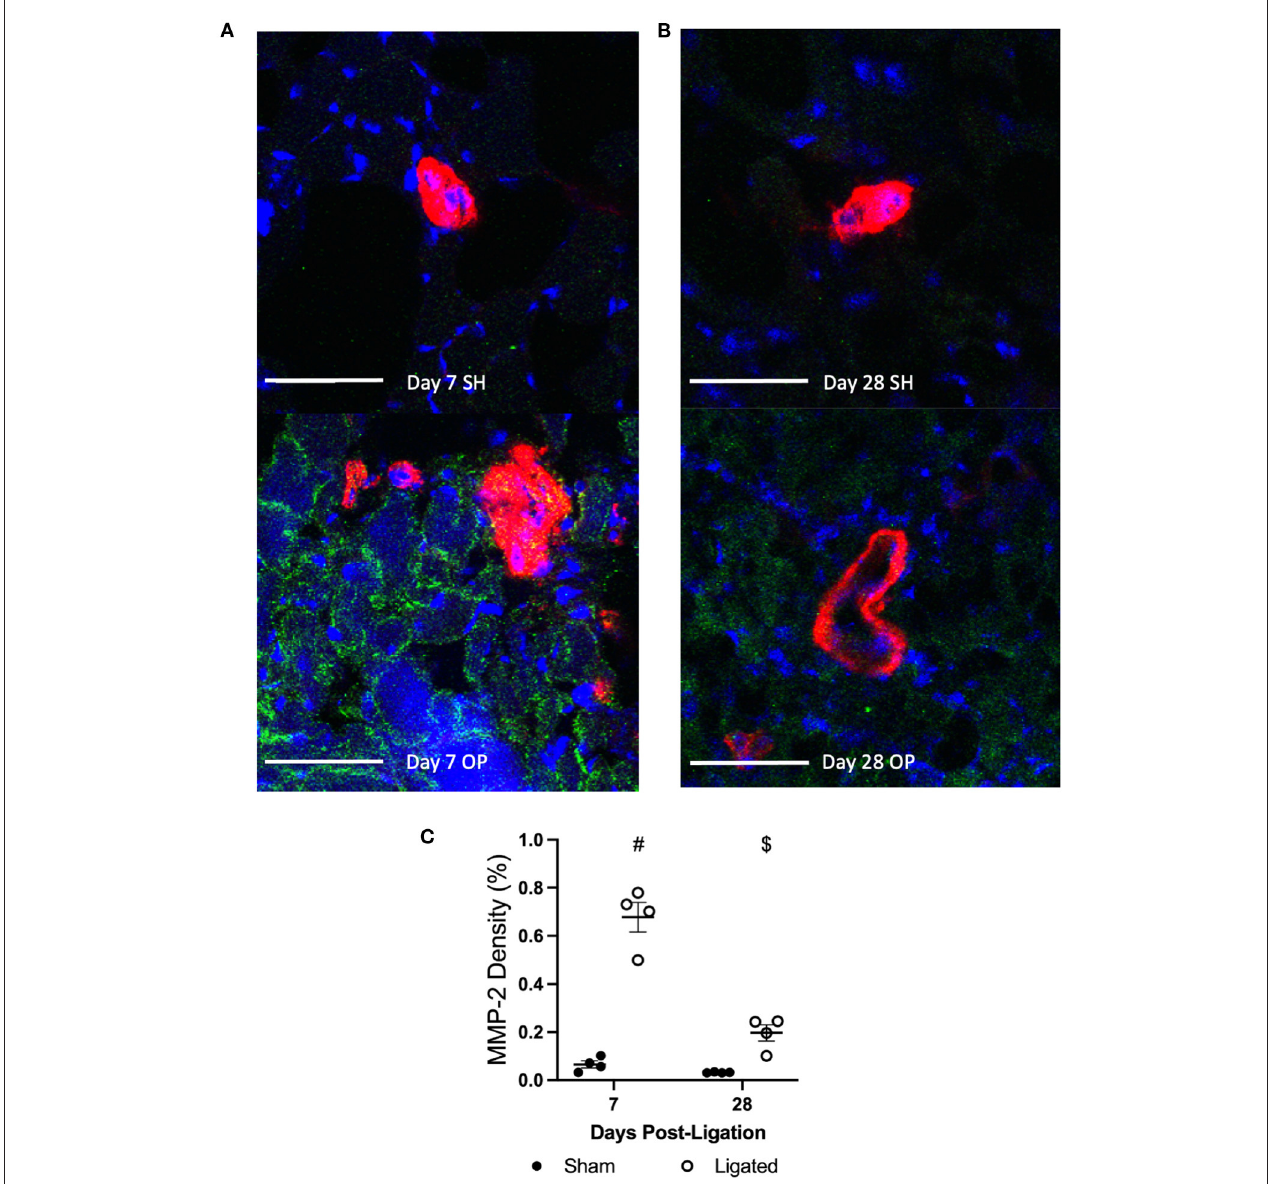
FIGURE 8 | MMP-2 is increased in the pericollateral region at day 7. Transverse cross sections of collateral vessel midzone was observed by confocal microscopy at 7 days (A) or 28 days (B) post-femoral artery ligation in the left mouse hindlimb after tissue sections of gracilis muscles from ligated (OP, bottom) and sham operated (SH, top) hindlimbs were incubated with anti- α -smooth muscle actin (collateral vessel, red), anti-MMP-2 (indicator of ECM degradation, green), and BBI (nuclei, blue); scale bar indicates 50 µ m. MMP-2 enzymes occupy more area in the peri-collateral region of enlarged collateral at 7 days ( C , n = 5, 3 male and 2 female) but not 28 days ( n = 4, 2 male and 2 female). # p < 0.05 vs. sham, $ p < 0.05 vs. day